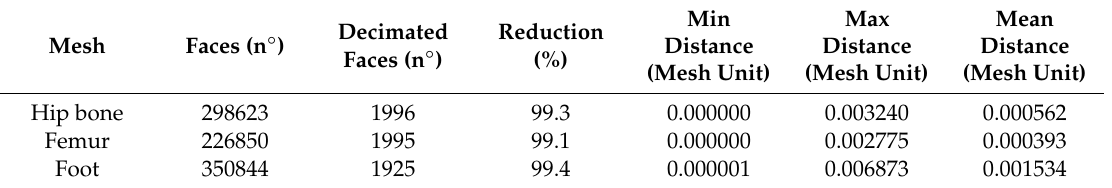
Table 1. Distance comparison between original and decimated